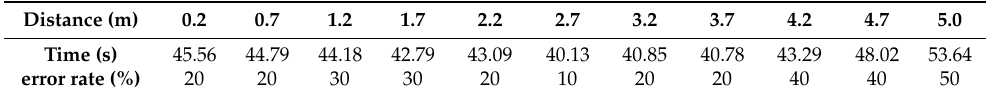
Table 2. The average time and error rate of the subjects to complete the task under different depth distances.